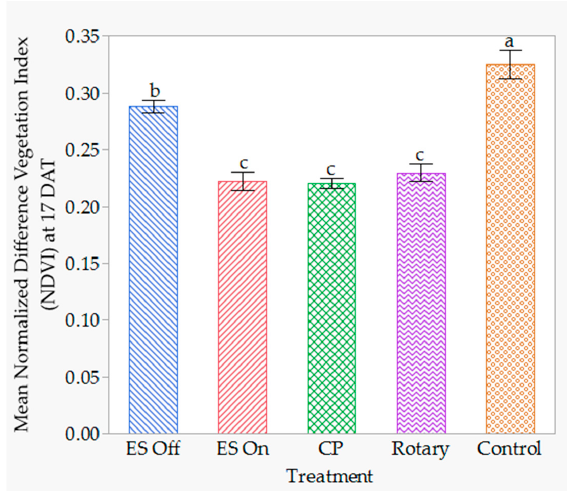
Figure 9. Mean NDVI (±SEM) obtained from ground-based remote sensing at 17 DAT. Means followed by the same lowercase letter are not significantly different ( p < 0.05) according to Tukey’s HSD test. The treatments described on the X -axis are electrostatically charged off (ES Off) and charged on (ES On) nozzles, the conventional hydraulic (CP) nozzle, and the rotary atomizer (Rotary) nozzle, compared with the Control.